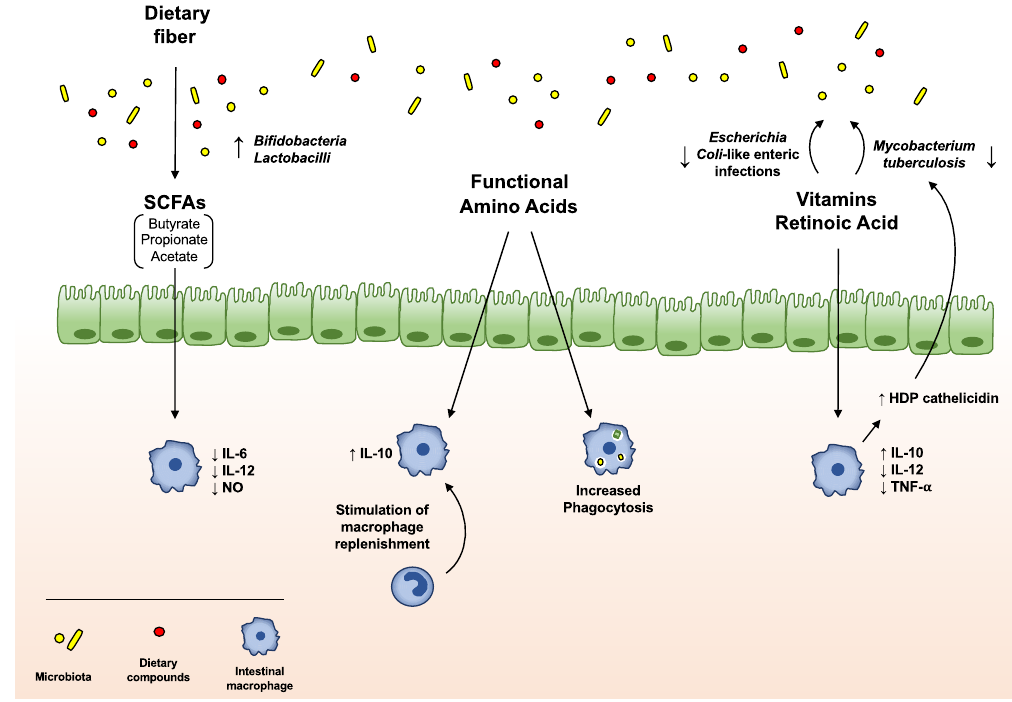
Figure 2. Impact of diet on macrophage / microbiota crosstalk. The microbial community regulates intestinal macrophage function via the release of specific compounds, often derived from the metabolism of dietary components. Dietary fiber is metabolized by intestinal microbes, leading to the production of the short-chain fatty acids (SCFAs) butyrate, propionate and acetate, which, in turn, promote the growth of specific beneficial microbiota species, including Bifidobacteria and Lactobacilli . In addition, these fermentation products modulate the immune response and macrophage activity, downregulating LPS-induced pro-inflammatory mediators, such as IL-6, IL-12, and NO. Dietary amino acids are able to regulate intestinal macrophage functions, increasing their phagocytic activity and stimulating the replenishment of intestinal macrophages, as well as their secretion of IL-10. Vitamins, in particular A and D, are involved in the control of intestinal macrophage functions. Vitamin A and its active metabolite retinoic acid (RA) attenuate intestinal inflammation in experimental models, reducing the synthesis of IL-12 and TNF- α , while increasing the production of IL-10, in LPS-stimulated macrophages. In addition, vitamin D suppresses the secretion of pro-inflammatory cytokines and directly stimulates the production of the host defense peptide (HPD) cathelicidin, required, in macrophages, for the anti-microbial activity against Mycobacterium tuberculosis. In addition, vitamin A and oral administration of RA are able to counteract the occurrence of Escherichia coli -like enteric and M. tuberculosis infections,